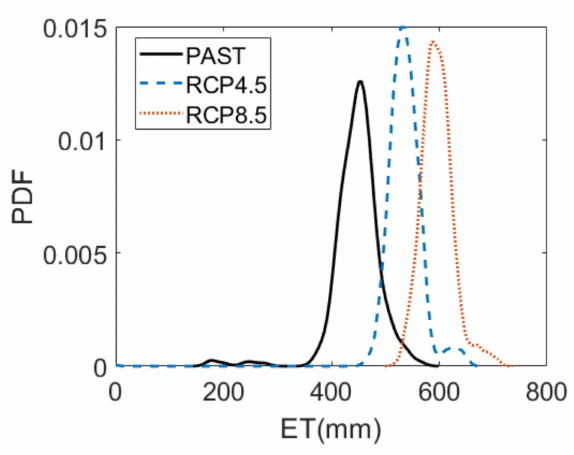
Figure 11. The annual level of the evapotranspiration rate under 3 different scenario